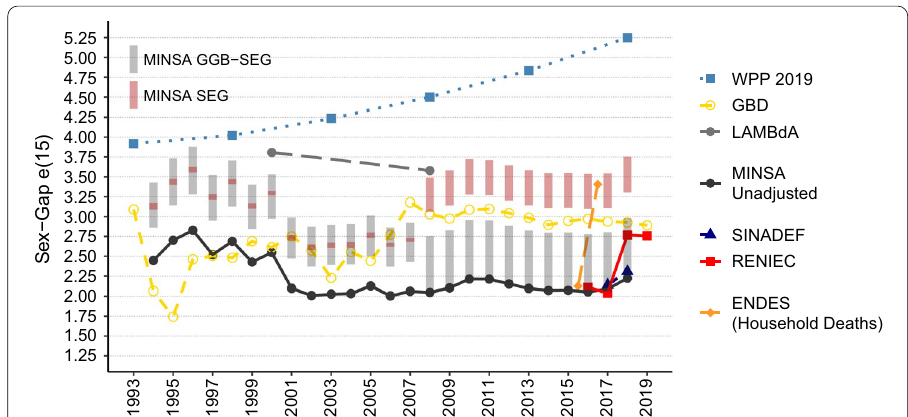
Fig. 2 Life expectancy at 15 year sex-gap estimates from MINSA, SINADEF, RENIEC, ENDES, WPP 2019, and GBD 2019 data by year and sex from 1990 to 2019, Peru. MINSA results were adjusted by GGB–SEG and SEG sensitivity analysis